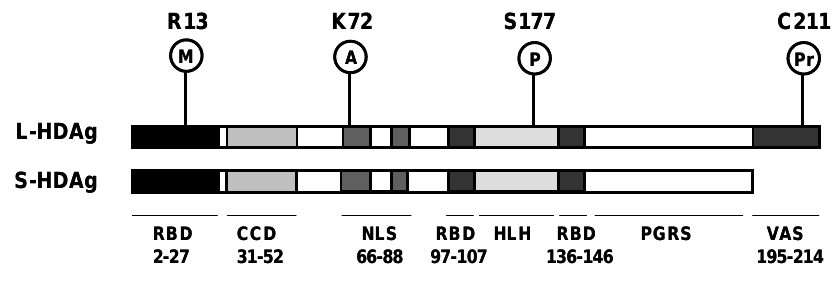
Figure 2. The functional domains and sites of posttranslational modifications of HDAg. RBD, RNA-binding domain; CCD, coiled-coil domain; NLS, nuclear localization signal; HLH, helix-loop-helix motif; PGRS proline/glysine-rich sequence; VAS, virus assembly signal; M, methylation; A, acetylation; P, phosphorylation; Pr,